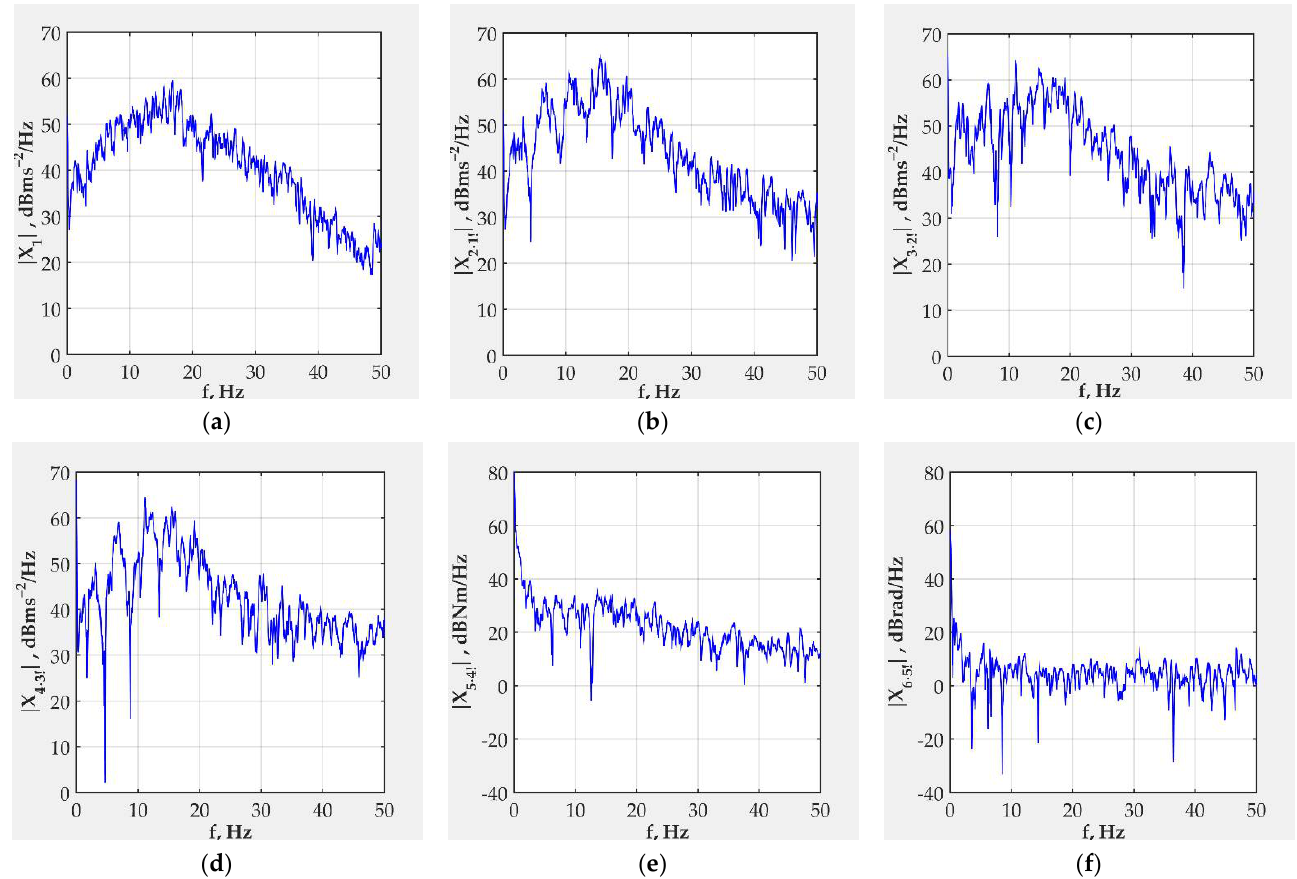
Figure 8. Magnitudes of spectra of ordered (decoupled) inputs: ( a ) X 1 ; ( b ) X 2 · 1! ; ( c ) X 3 · 2! ; ( d ) X 4 · 3! ; ( e ) X 5 · 4! ; ( f ) X 6 · 5!